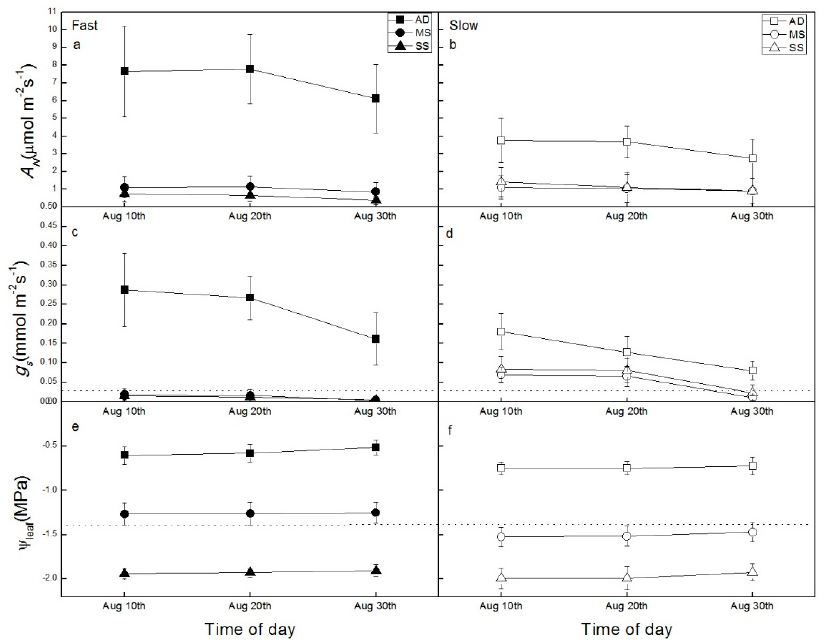
Figure 5. Changes of net photosynthesis ( A N ) ( a , b ), stomatal conductance ( g s ) ( c , d ) and leaf water potential ( ψ leaf ) ( e , f ) for fast (filled symbol) and slow genotypes (empty symbol) (I-101 ( Populus alba L.) × 84K ( Populus alba L. × Populus glandulosa Uyeki)) during August treatment (square for AD plants, circle for MS plants and triangle for SS plants, which represent control plants, moderately water-stressed plants and severely water-stressed plants, respectively). The A N and g s data are means ± SE from four to six fully exposed leaves; ψ leaf data are means ± SE of three leaves per treatment.